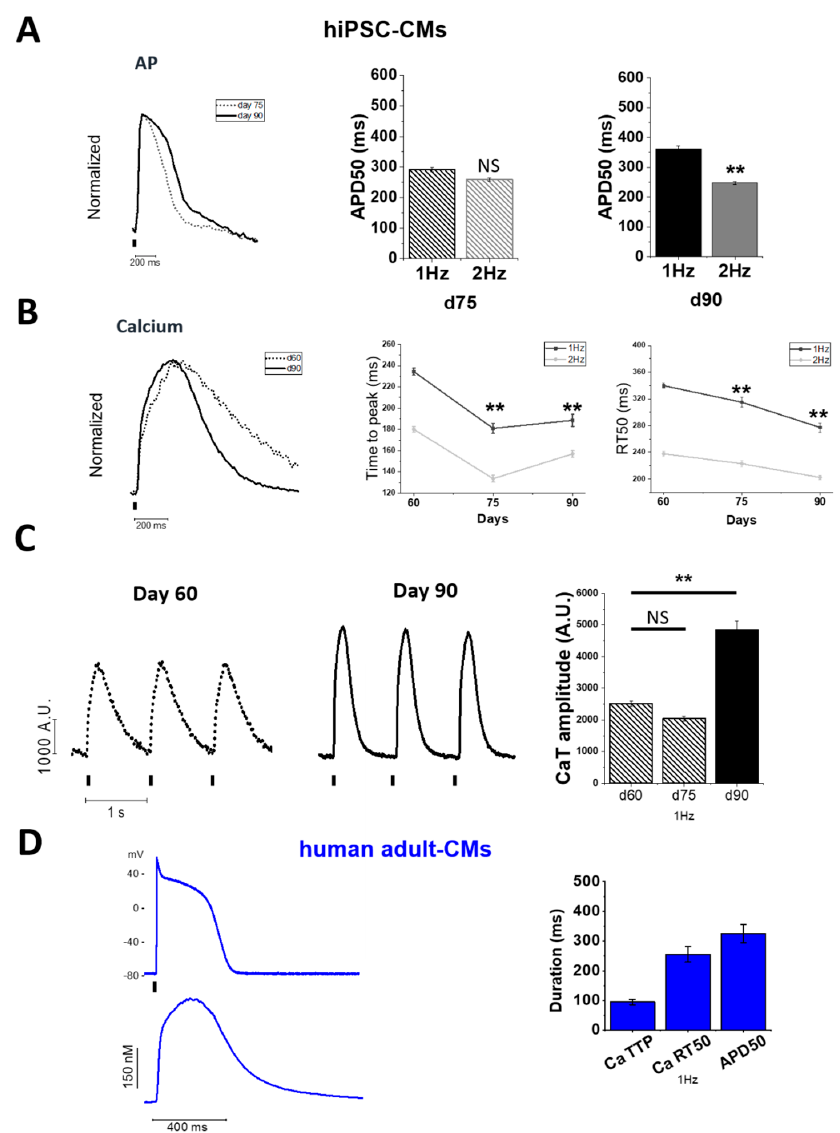
Figure 2. Dual recording of action potential and calcium transient in later-stages hiPSC-CMs. Single hiPSC-CMs matured on hydrogel-based micropatterned surfaces were subjected to simultaneous optical measurements of action potentials and calcium transients under electrical pacing (1 and 2 Hz) at 37 ◦ C at and external [Ca 2 + ] = 1.8 mM. ( A ) Superimposed action potential (AP) traces of day 75 ( N = 2; n = 186) vs. day 90 ( N = 2; n = 119) recorded by FluoVolt. AP profile of hiPSC-CMs was recorded both at 1 and 2 Hz to evaluate action potential duration (APD50, ms) and the response to frequency changes at both day 75 and 90. ( B ) Superimposed normalized traces of calcium transients recorded by Cal630 at day 60 ( N = 3; n = 336), 75 ( N = 5; n = 251) and 90 ( N = 3; n = 165): average calcium transient (CaT) rise (time to peak TTP, ms) and CaT decay (di ff erence of 50% of CaT decay and TTP, RT50, ms) are reported, during pacing at 1 and 2 Hz ( C ) Representative CaT profiles at day 60 and 90 and average CaT amplitude (in arbitrary fluorescence units, A.U.) at day 60,75 and 90. ( D ) Representative simultaneous recordings of action potential and intracellular calcium transient from adult ventricular cardiomyocytes, elicited with short current pulses in current-clamp mode at 1 Hz. Average time to peak (Ca TTP) and time from peak to 50% decay (Ca RT50) of Ca transients, and time from stimulus to 50% repolarization (APD50) of action potentials at 1 Hz. Means ± SEM from 27 myocytes (nine control patients). Data are reported as means ± SEM; one-way analysis of variance (ANOVA) with a Tukey post-hoc test with statistical significance set at * p < 0.05 and ** p < 0.01; NS not significant. Supporting information given in Table S2. N = number of di ff erentiations; n =